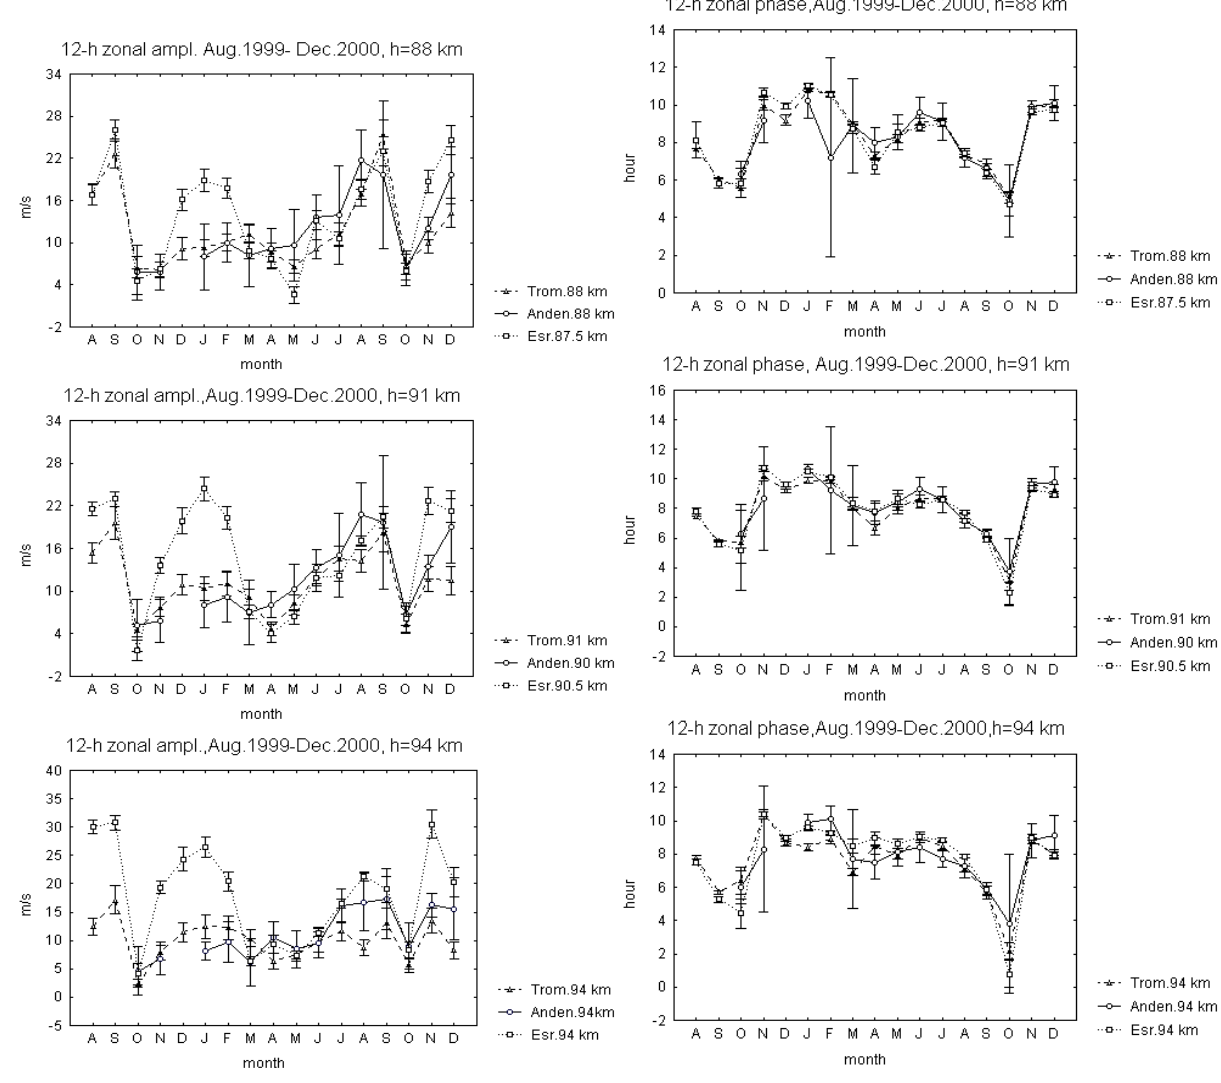
Fig. 2. ( a ) Monthly mean amplitudes of zonal component of the diurnal tide measured at “Scandinavian triangle”. ( b ) Monthly mean phases of zonal component of the semidiurnal tide measured at “Scandinavian